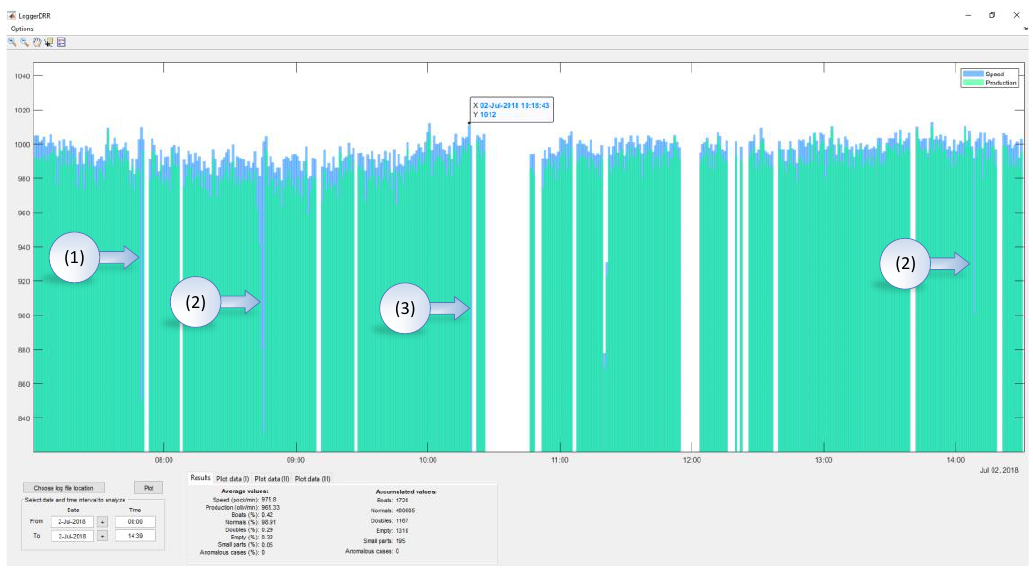
Figure 20. Instantaneous values of speed and production.